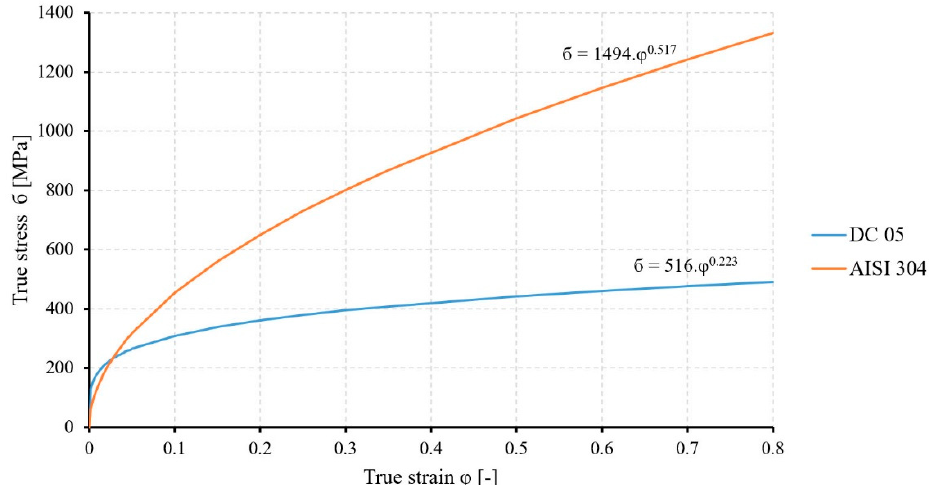
Figure 9. Comparison of hardening laws for experimental materials.